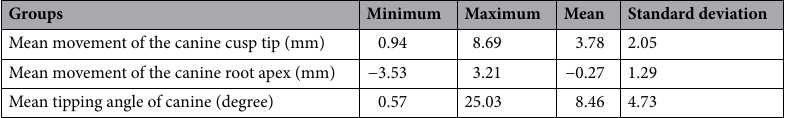
Table 2. Distances travelled by the canine cusp tip and root apex and canine tipping after 4 months of active retraction. Positive sign means distal movement (mm), negative sign means mesial movement (mm).